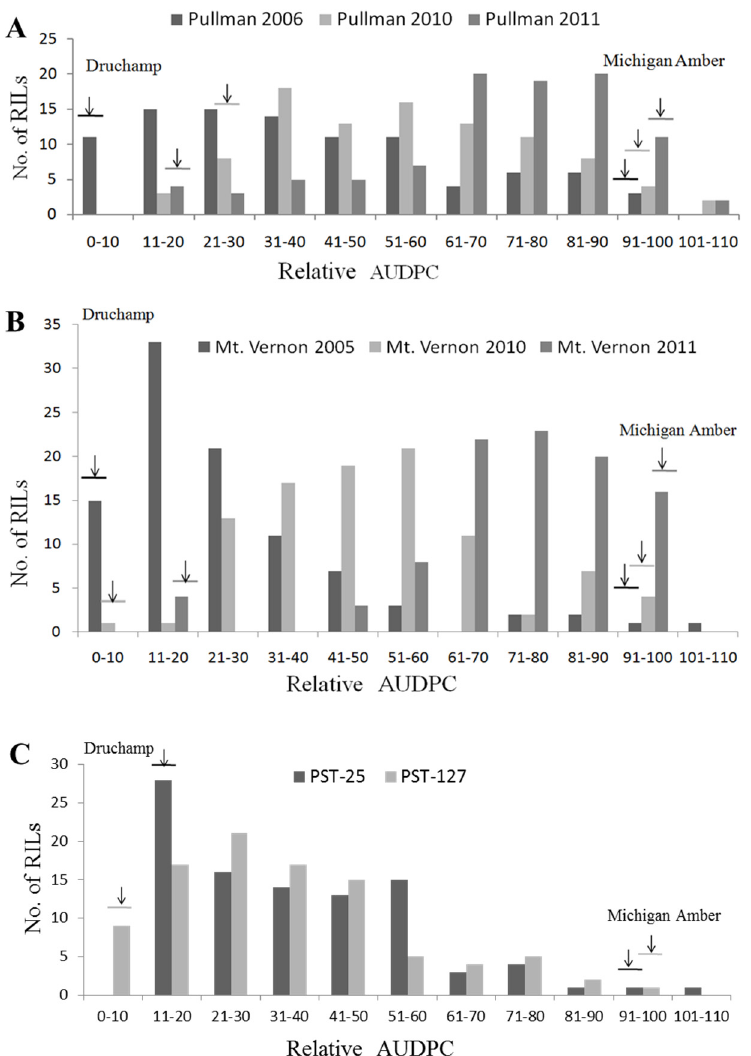
Fig 2. Frequency distributions of mean relative area under the progress curve (rAUDPC) values in Druchamp × Michigan Amber derived recombinant inbred lines tested with Puccinia striiformis f. sp. tritici in various environments. rAUDPC distribution of: ( A ) Pullman, WA in 2006, 2010 and 2011; ( B ) Mt. Vernon, WA in 2005, 2010 and 2011; and ( C ) greenhouse with races PST-25 and